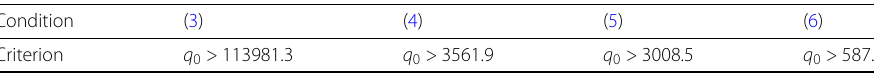
Table 1 Conditions comparison